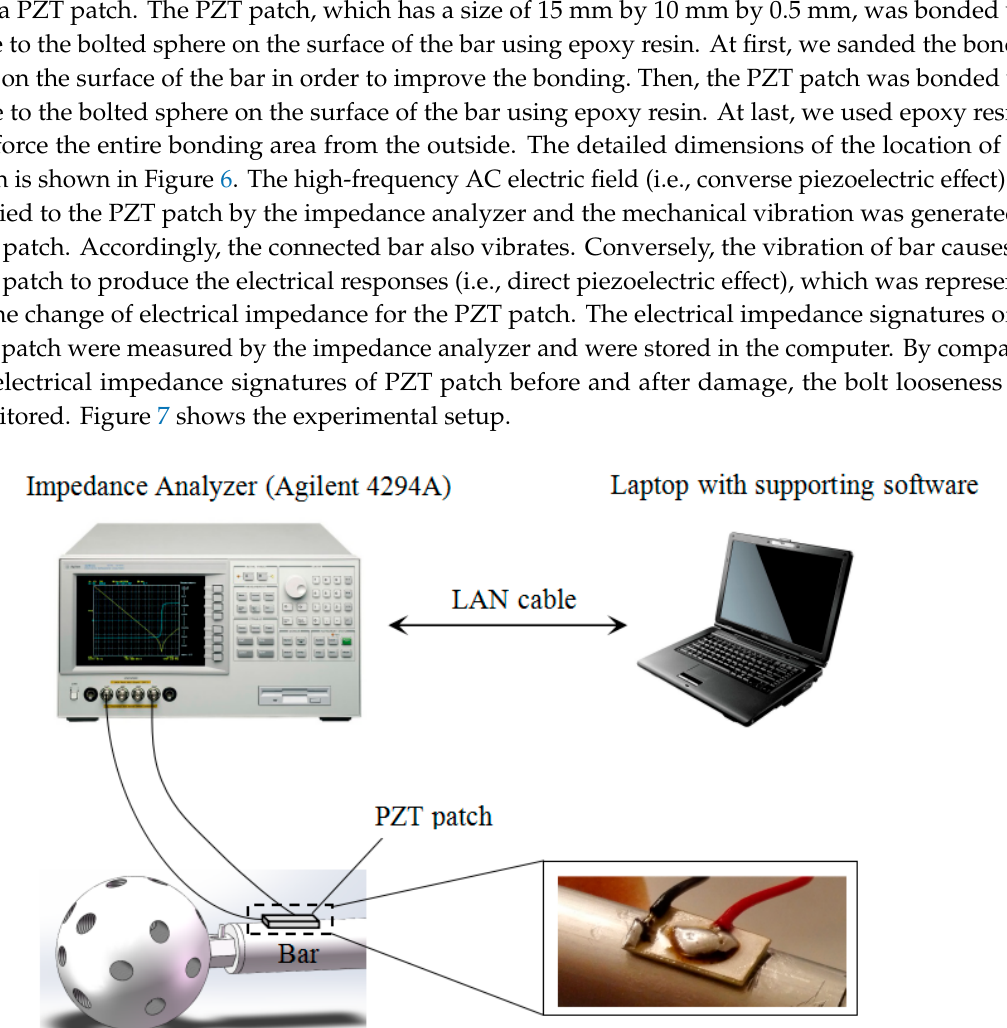
Figure 4. ( a ) Installation schematic representation of bolted spherical joint ( b ) Photo of bolted spherical joint connection.